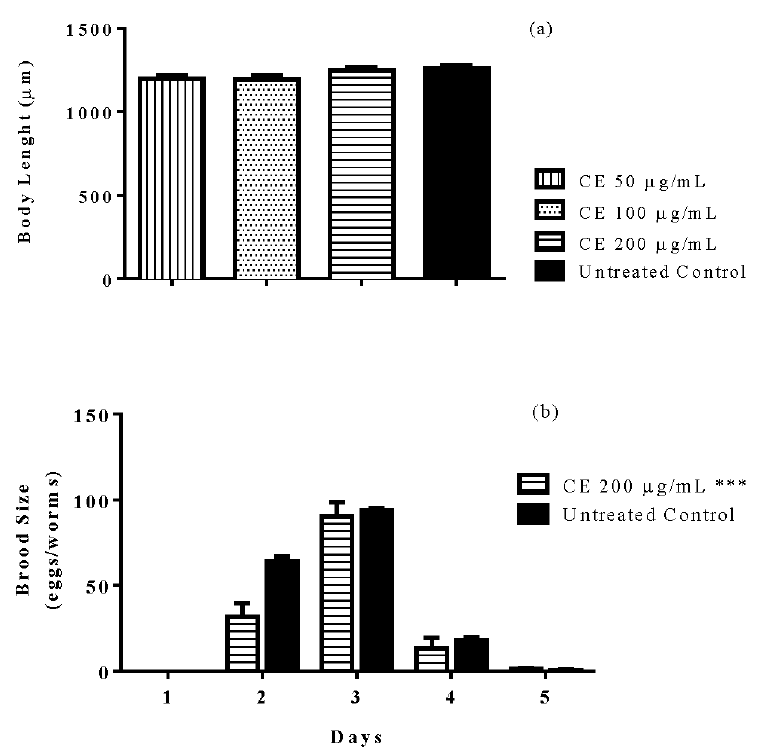
Figure 7. Brood size and body length of worms after treatment with C. spruceanum extract (CE). The treatment of N2 (wt) worms did not impair the body development ( a ), but significantly decreased the brood size of treated worms ( b ). Data are presented as mean ± SEM. *** p < 0.0001 related to the control by two-way